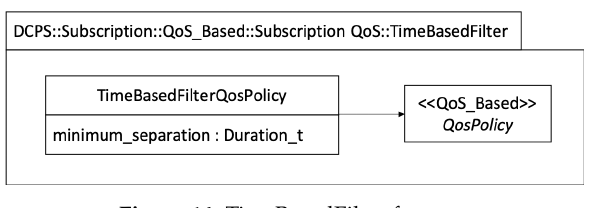
Figure 14. TimeBasedFilter